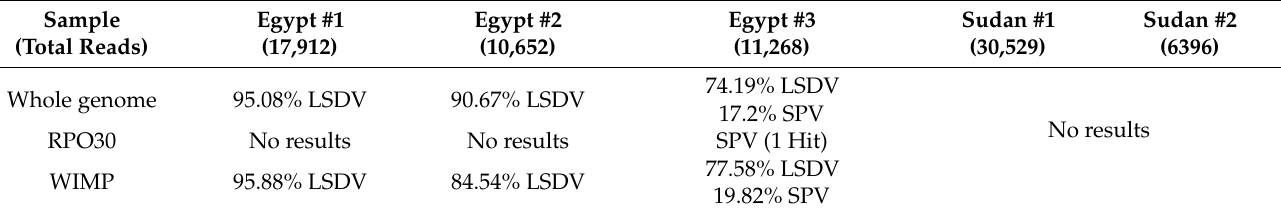
Table 3. Results of validation runs using samples from Egypt and Sudan, presented as percentage of mappings in offline BLAST and WIMP. Total number of correctly assigned hits is around 1% of the total number of reads. Most of the reads are background of host genome. The percentages in the table represent the specificities of the BLAST.